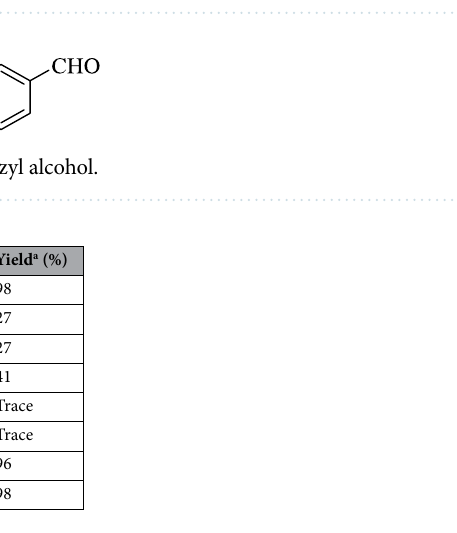
Table 5. The effect of different catalysts on the oxidation of benzyl alcohol. a Isolated yield. Reaction conditions: benzyl alcohol (1 mmol), TBHP (6 mmol) at 90 °C. b Amount of the catalyst is based on W, Mo or V